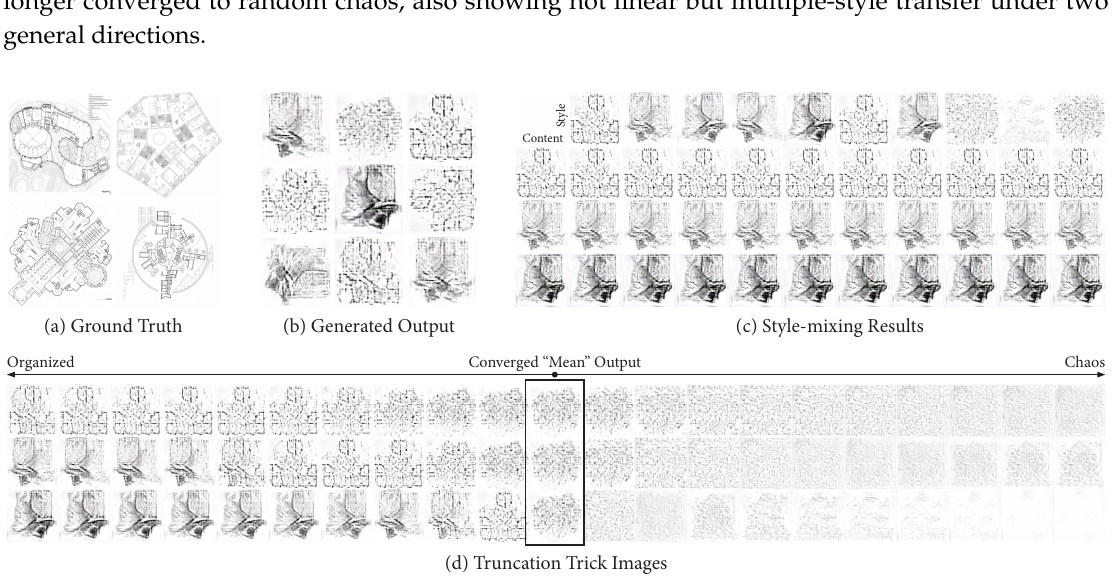
Figure 3. These are the training processes and results of collected plan drawings: ( a ) Example of input data. ( b ) Selected output fake images. ( c ) Contents, styles, and mixed results. ( d ) Continuing transforming images